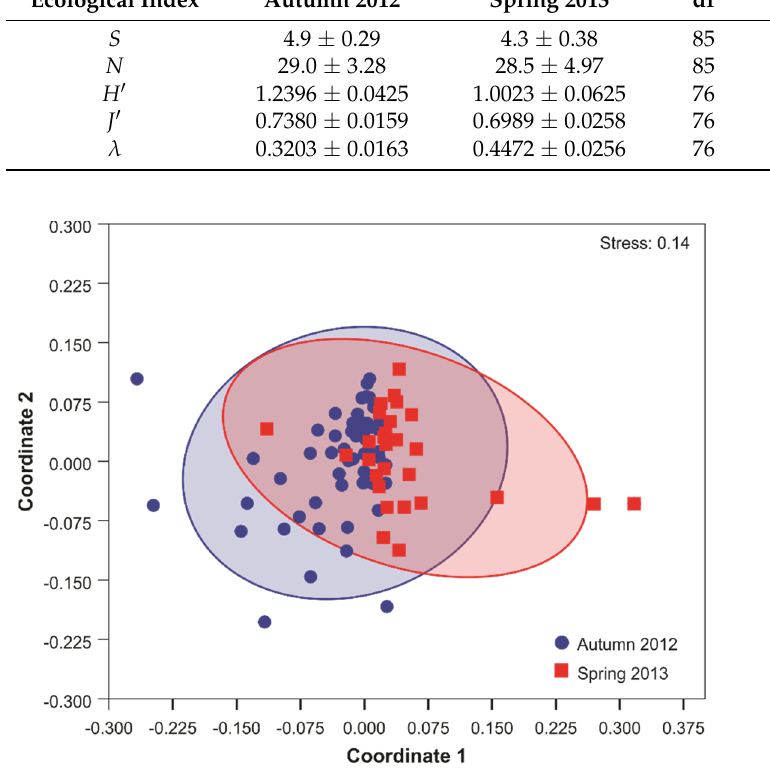
Figure 11. Non-metric multi-dimensional scaling ordinations (NMDS) for the phyllosomata assem- blage structure in plankton samples obtained with the Tucker trawl in the autumn cruise (blue dots) and the spring cruise (red dots). The ordinations show the 95% concentration ellipses.